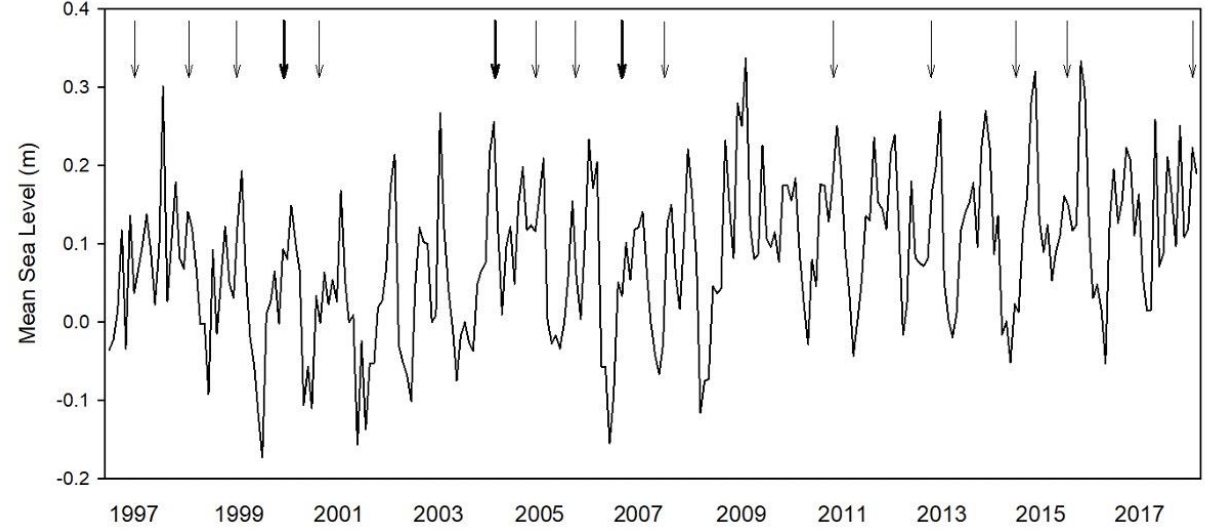
Figure 2. Mean sea level over the time period from 1997 to 2018 from Chesapeake Bay Bridge Tunnel, VA. Hurricanes and tropical storms that came within a 100 mi radius of Parramore Island are indicated by arrows. Bold arrows indicate more than one storm within that year.